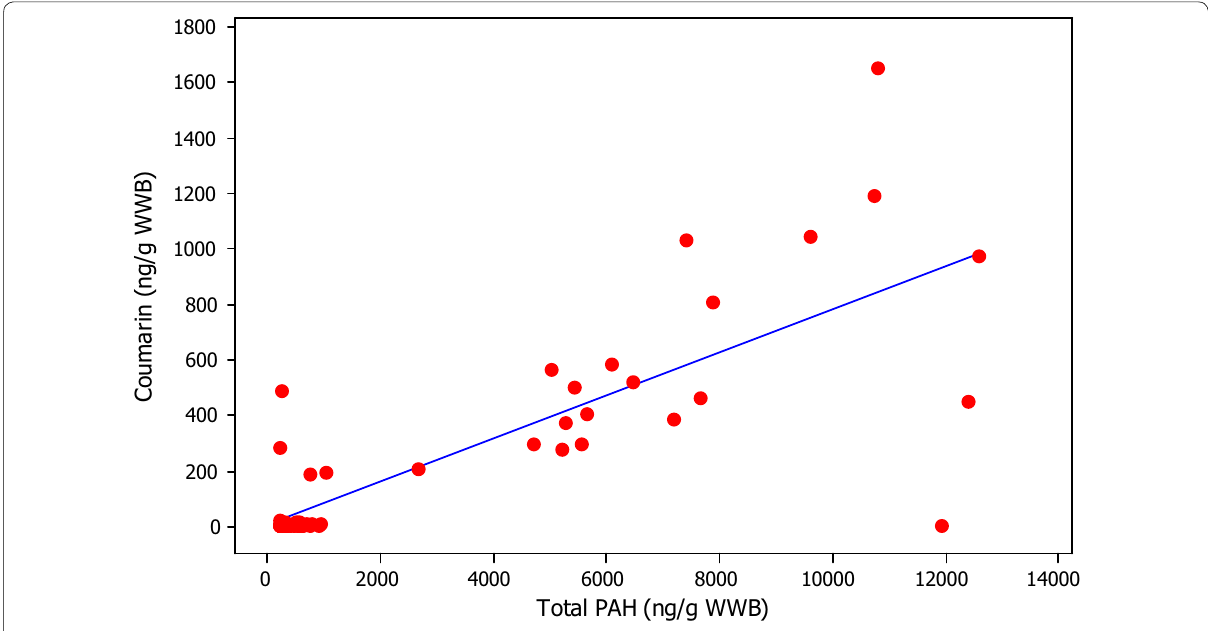
Fig. 5 Coumarin vs total PAH in STPs (r